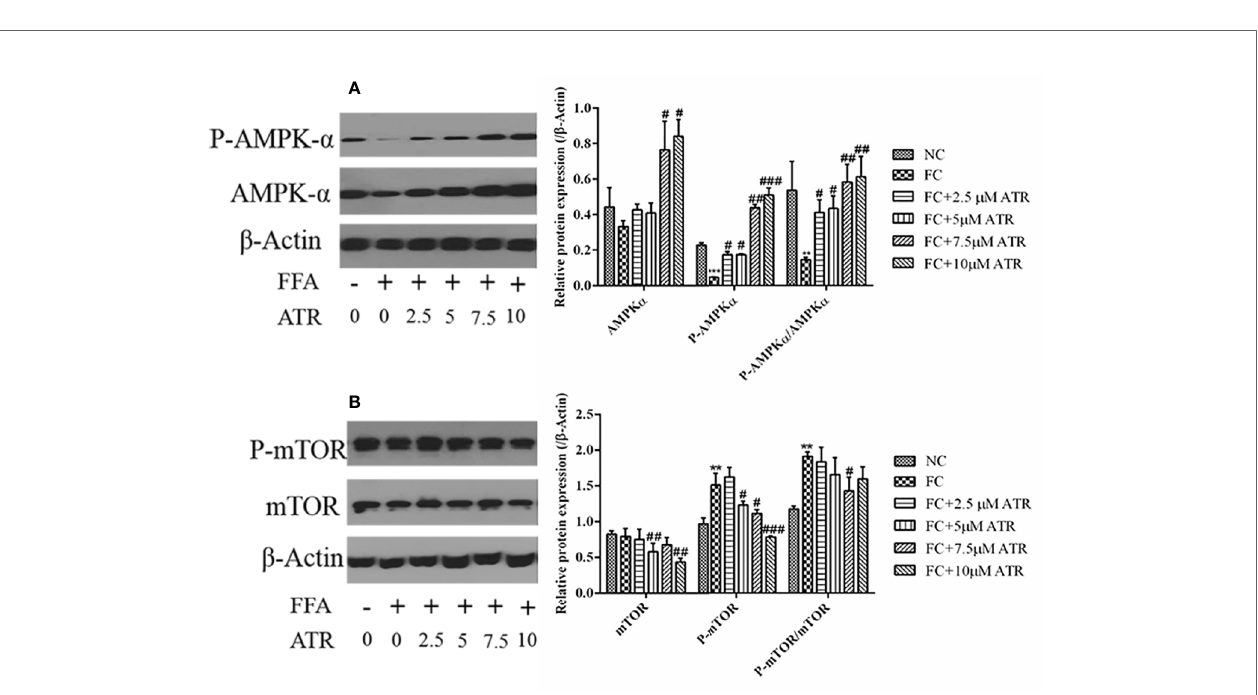
FIGURE 4 | Effect of ATR on the protein expression of AMPK a and mTOR in FFA-treated HepG2 cells. (A) Immunoblot analysis for AMPK- a , phosphorylated AMPK a (p-AMPK a , Thr 172), and relative protein expression in reference to b -actin. (B) Immunoblot analysis for mTOR, phosphorylated mTOR (p-mTOR, Ser 2448), and relative protein expression in reference to b -actin. Data are expressed as mean ± SD (n=3). **P<0.01, ***P<0.001 (*represents the FC group compared with the NC group). # P<0.05, ## P<0.01, ### P<0.001 ( # represents FC+ATR treatments compared with the FC group). NC=normal group, and FC=FFA